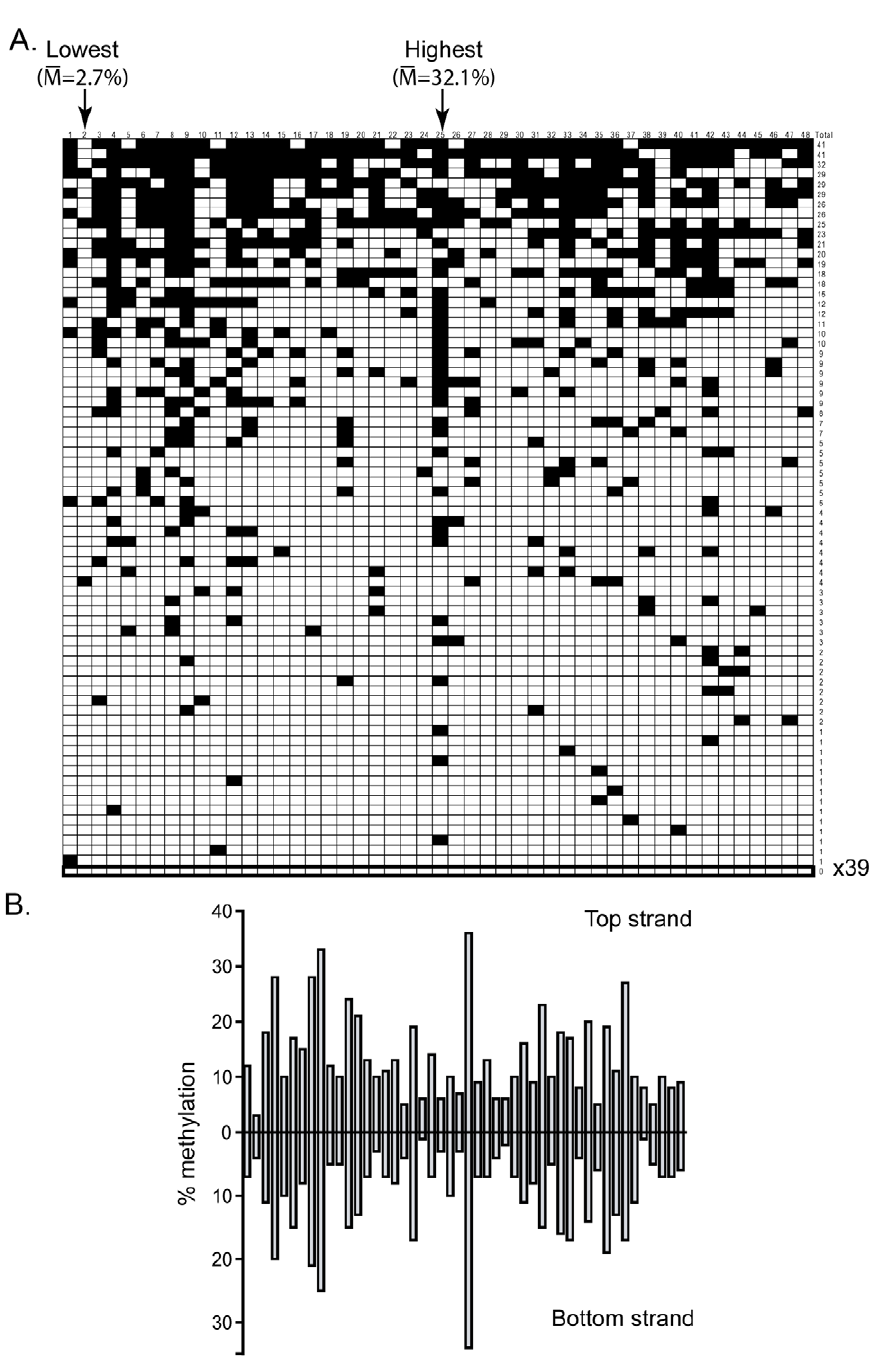
rich strand (maximal fold difference between the most and least methylated sites: 5.6 and 23-fold for DNMT3A and DNMT3B,